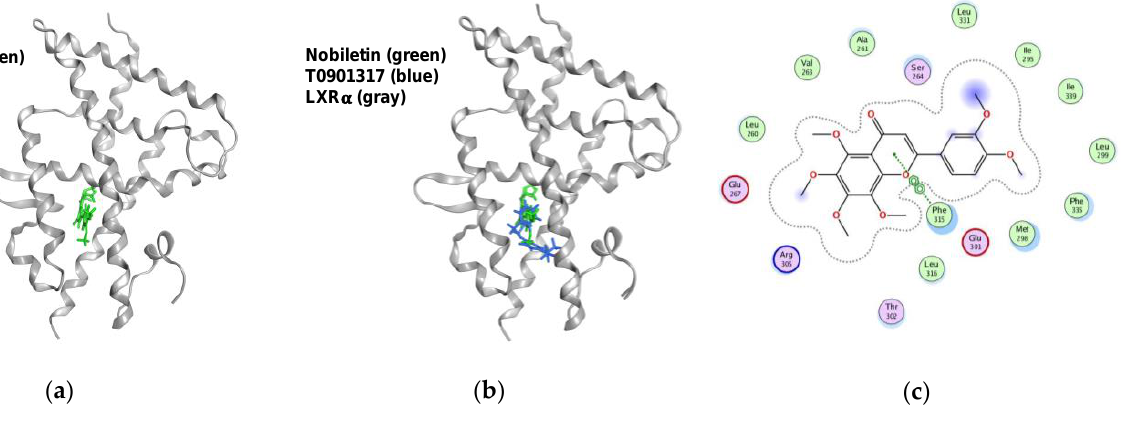
Figure 6. The poses of nobiletin docked into the ligand-binding domain (LBD) of LXR α. ( a ) The LXRα receptor is shown as a gray ribbon, and nobiletin is shown in green. ( b ) Superposition of both nobiletin and T0901317 (blue) bound to the LBD of LXRα. ( c ) Two-dimensional interaction map of LXRα and nobiletin. Nobiletin is surrounded by hydrophobic residues (green) and hydrophilic residues (pink) within the LBD of LXRα. Dotted line indicates a stacking interaction between the heterocyclic ring of nobiletin and the aromatic group of the phenylalanine (Phe315) residue.